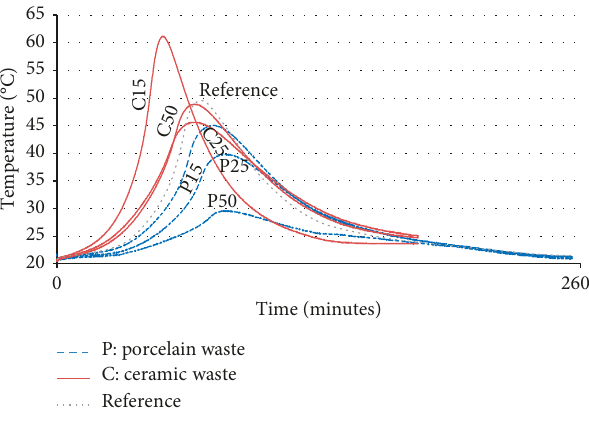
Figure 5: Kinetics of temperature